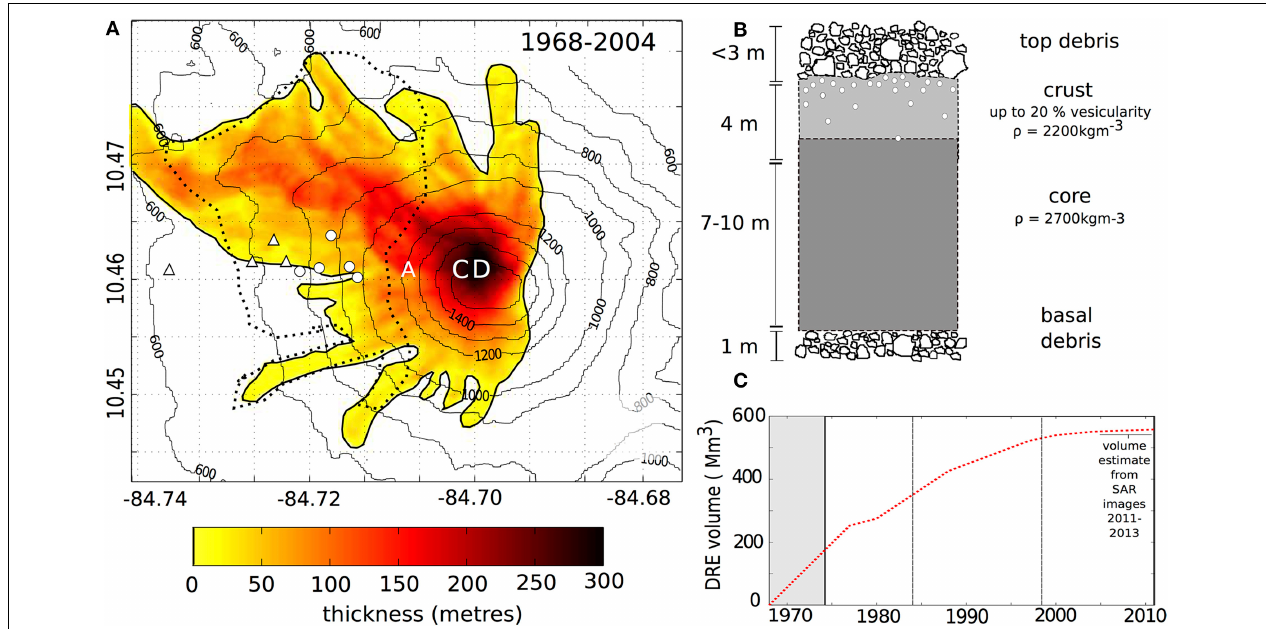
FIGURE 1 | (A) Lava thickness map of Arenal, after Wadge et al. (2006), showing change in topography since 1968. Contours show SRTM topography (2000). Letters A, B, and C mark the location of craters than opened during the 1968 blast eruption. Since 1973, only Crater C has been active. The dotted line indicates the previous spatial limits of InSAR measurement (Ebmeier et al., 2010), circles show the positions of reflectors used in Electronic Distance